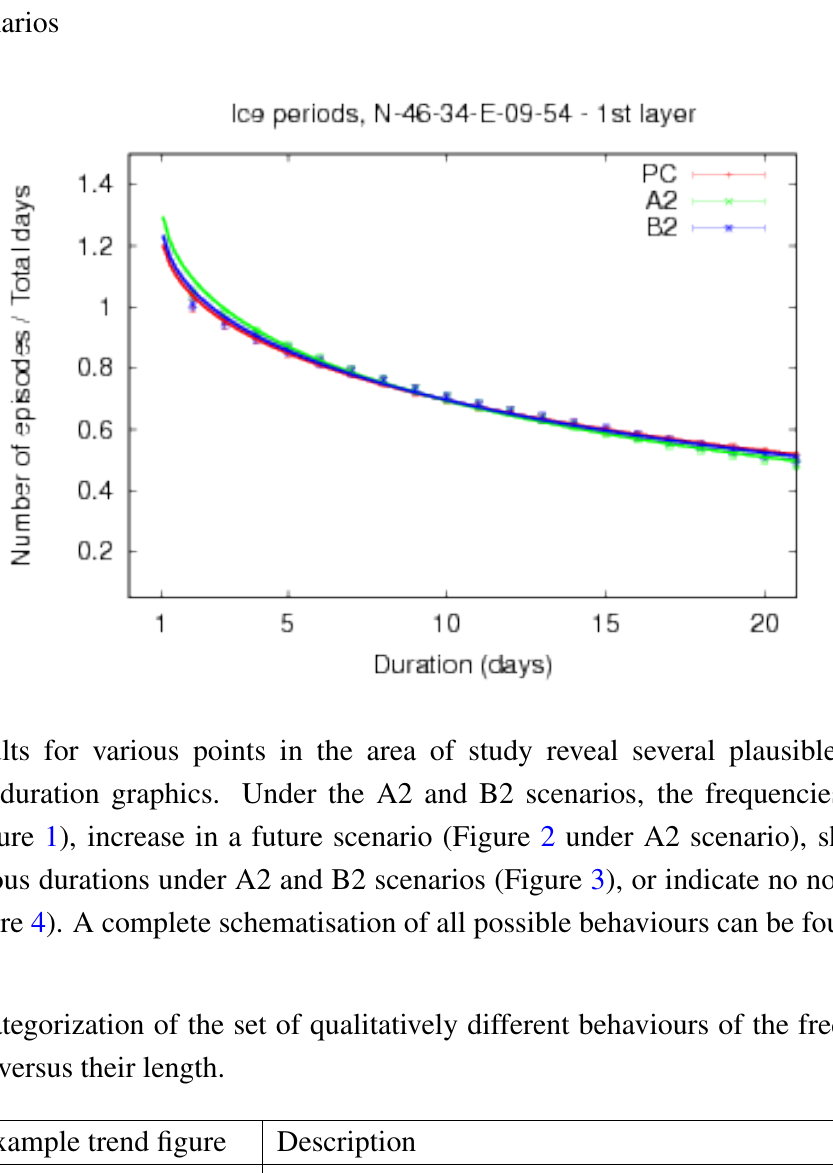
Figure 4. Frequency of cold spells versus their duration: the case of no difference in the climate scenarios